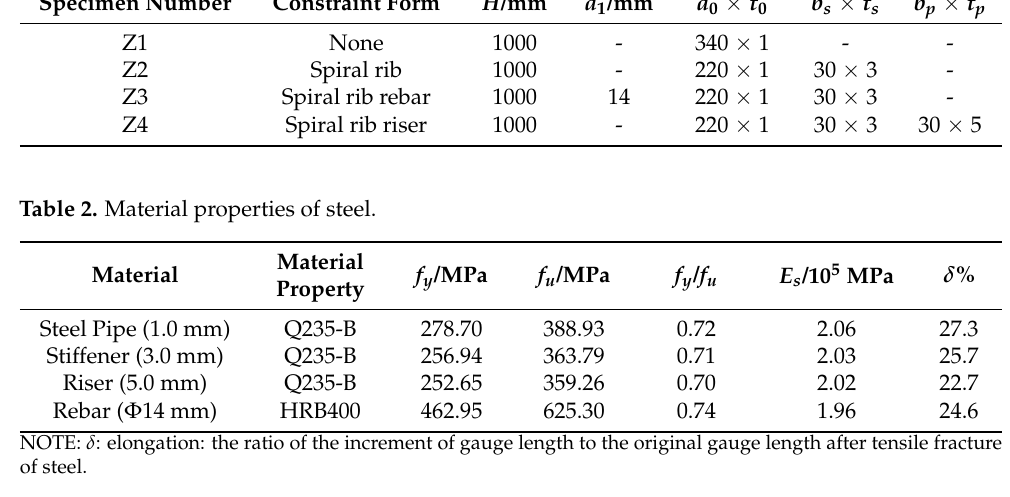
Table 3. Material properties of concrete.